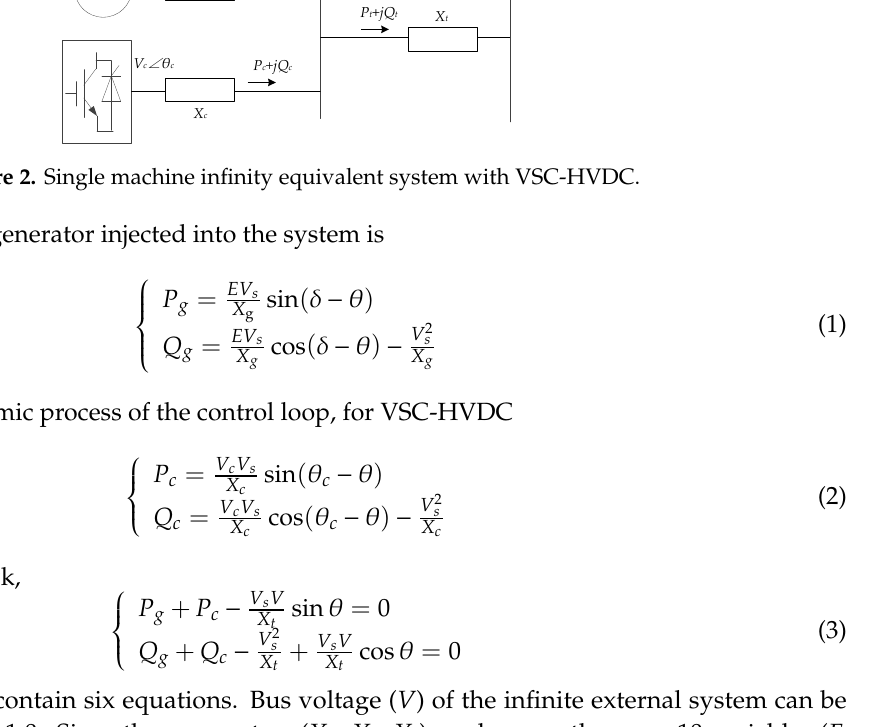
Figure 2. Single machine infinity equivalent system with VSC-HVDC.